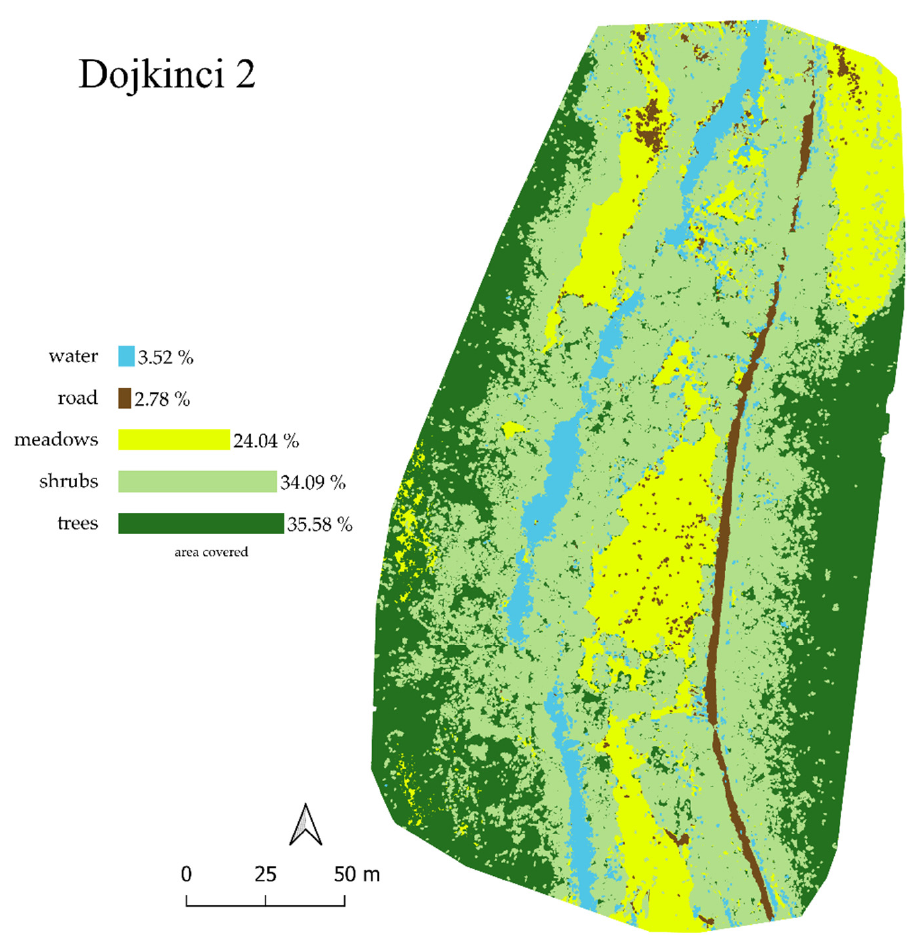
Figure 6. Map of the land cover classification for the study site Dojkinci2 obtained by RF classification algorithm.